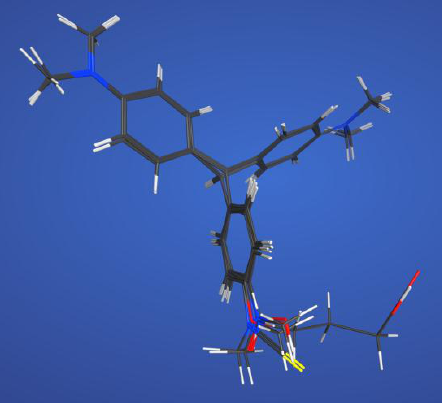
Figure 2. Superimposed structures of MG, CV, LMG, LCV, and the haptens listed in Table 1.